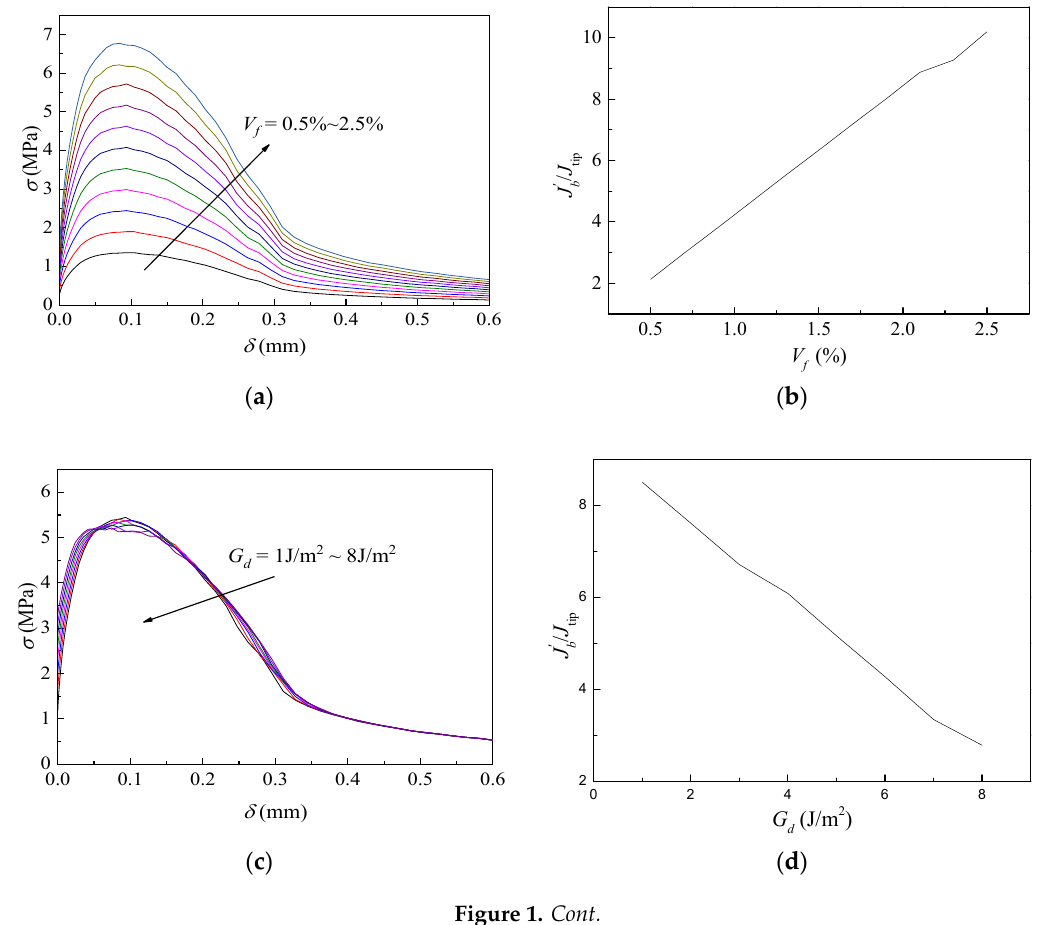
Table 1. Parameters used in the analysis with fiber-bridging